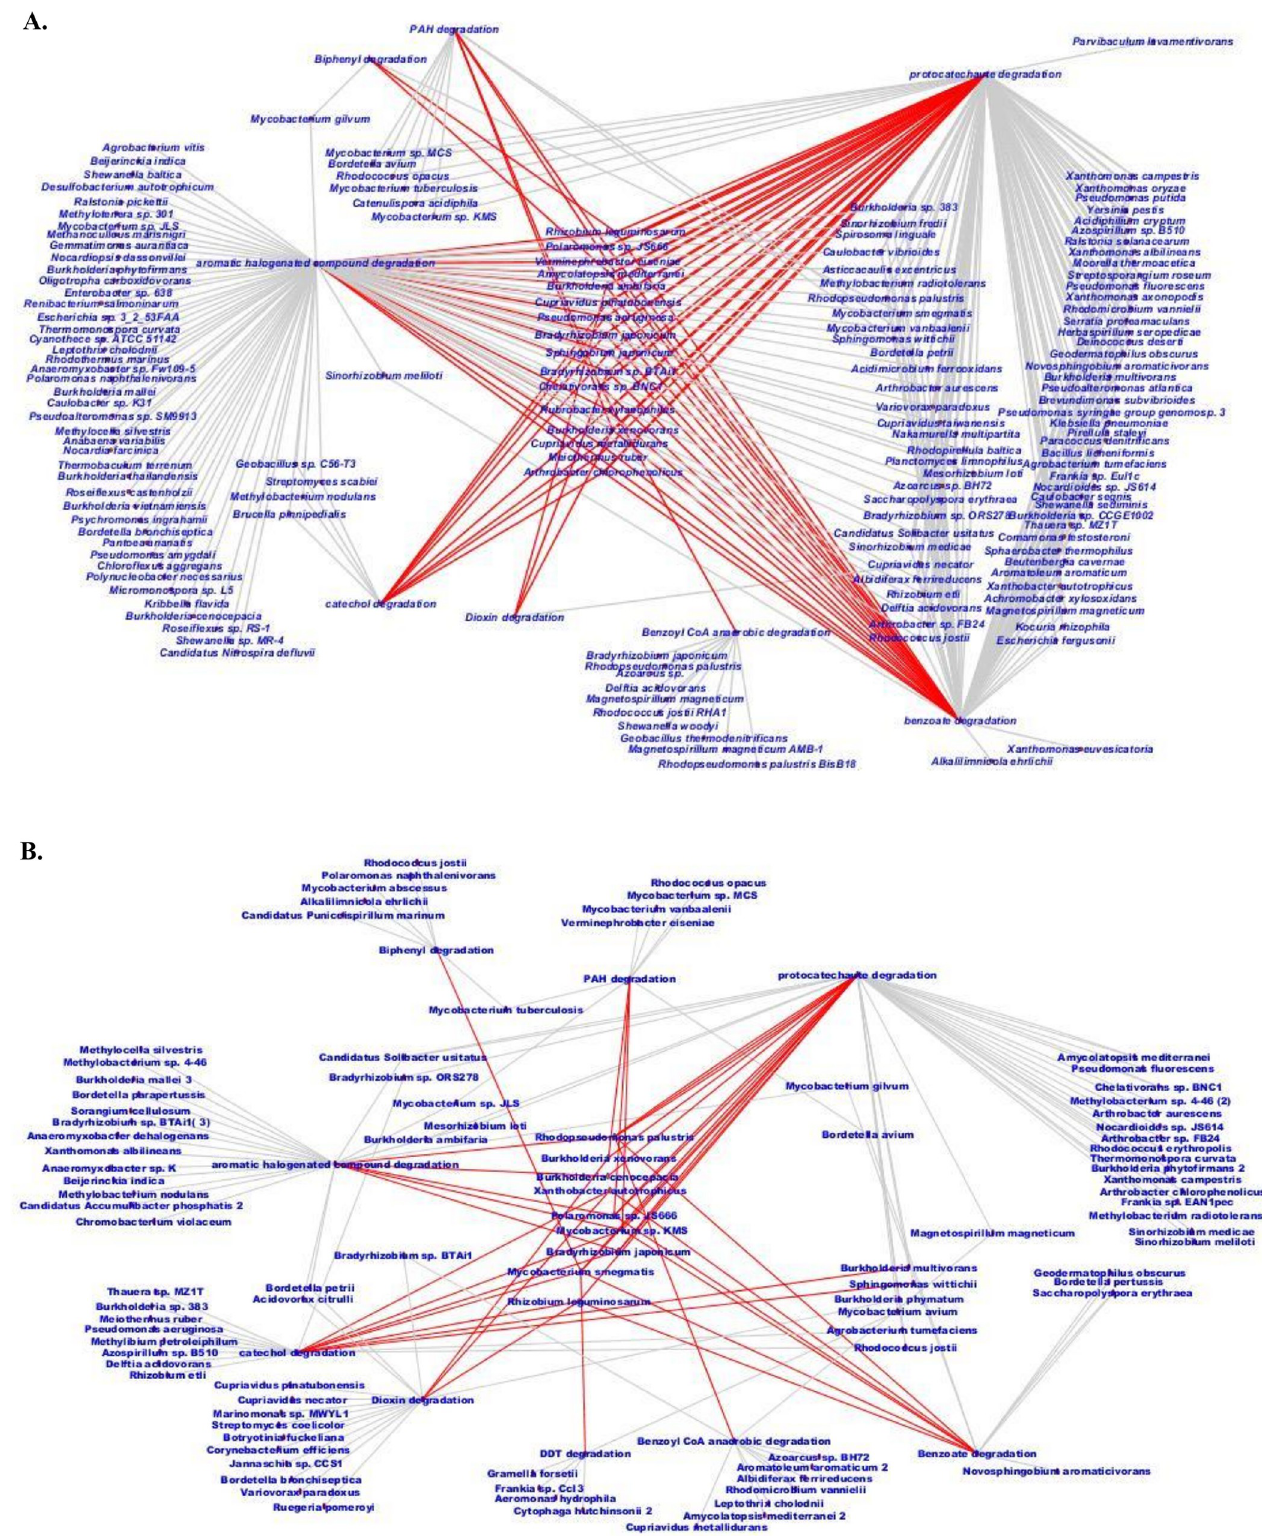
Fig 6. Cytoscape-based networking depicted interrelationship of key biodegraders in PAH, biphenyl, dioxin, halogenated, catechol and protocatechuate pathways Key biodegraders presented in the middle and the interrelated pathways are given in red lines (A) MGB-2 (B) MGB-3.